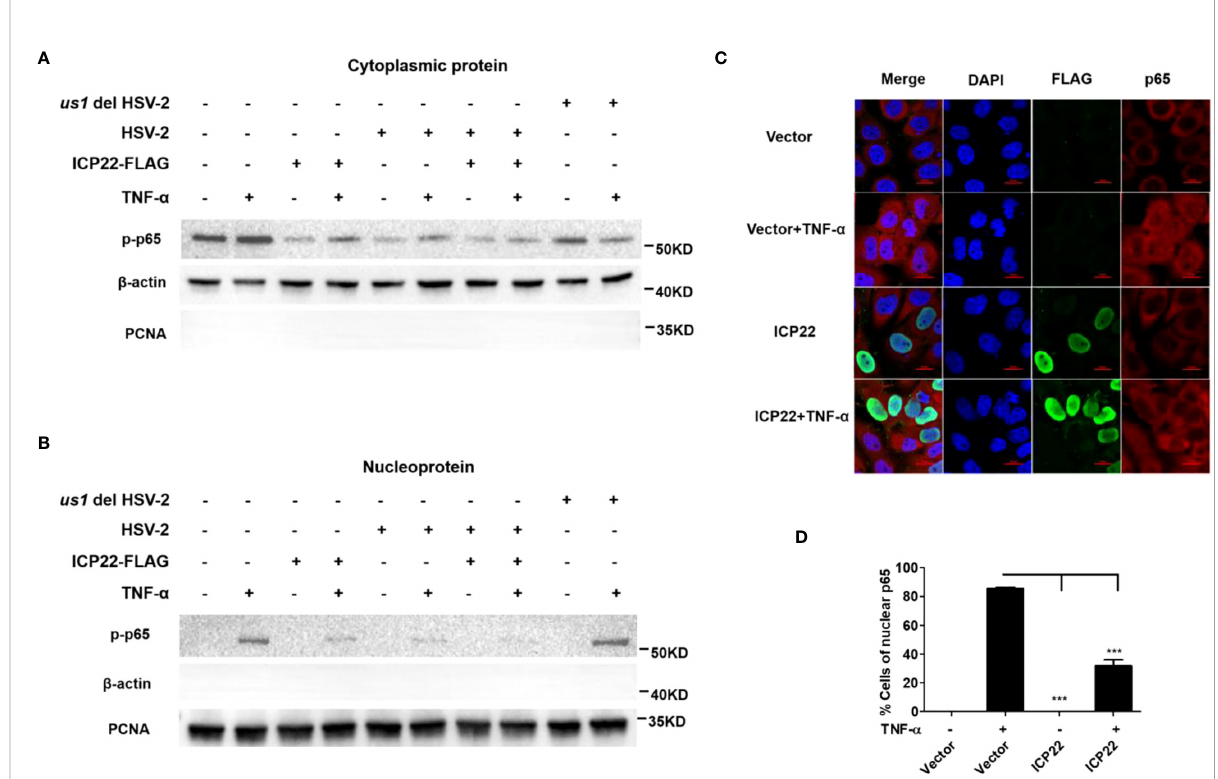
FIGURE 4 HSV-2 ICP22 inhibits the phosphorylation and nuclear translocation of p65. (A, B) . HSV-2 ICP22 inhibits the phosphorylation of p65. HeLa cells seeded in the 6 well plates were transfected with empty vector or ICP22-expressing plasmid. At 4 h post-transfection, cells were mock infected or infected with HSV-2 or us1 del HSV-2 at an MOI of 1. At 20 h post-infection, cells were stimulated with or without TNF- a (20 ng/ml) for 6 h. The phosphorylated p65 in the cytoplasm and nucleus were detected by western blot. b -actin and PCNA were used as loading controls for cytoplasmic and nuclear proteins, respectively. (C, D) . HSV-2 ICP22 signi fi cantly inhibits the nuclear translocation of p65. HeLa cells were transfected with ICP22-expressing plasmid or empty vector. At 24 h post-transfection, cells were stimulated with or without TNF- a (20 ng/ml) for 6 h. Cells were stained using the mouse anti-Flag and the rabbit anti-p65 Ab. Alexa Fluor 488-conjugated goat anti-mouse (green) and Alexa Fluor 647-conjugated goat anti-rabbit (red) were used as secondary antibodies. Cell nuclei (blue) were stained with DAPI. The images were obtained by fl uorescence microscopy using a 60× objective. The percentage of p65-positive nuclei was quanti fi ed in a number of fi elds (D) . The scale bar indicates 20 m m. For graphs, data shown are mean ± SD of three independent experiments with each condition performed in triplicate. For images, one representative experiment out of three is shown. ***p <